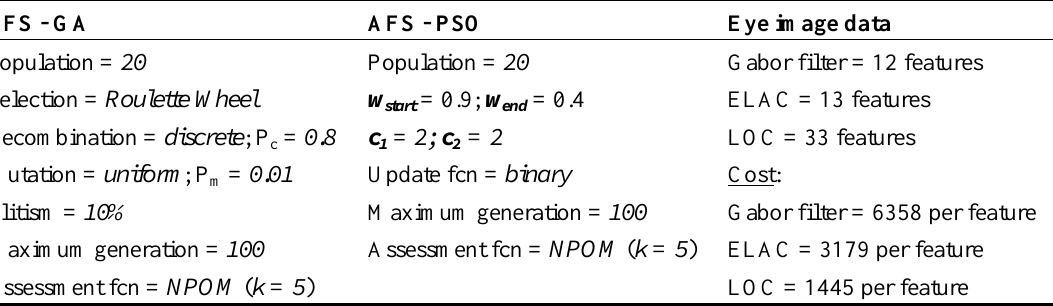
Table 7. Parameter settings of GA and PSO, as well as the acquisition cost